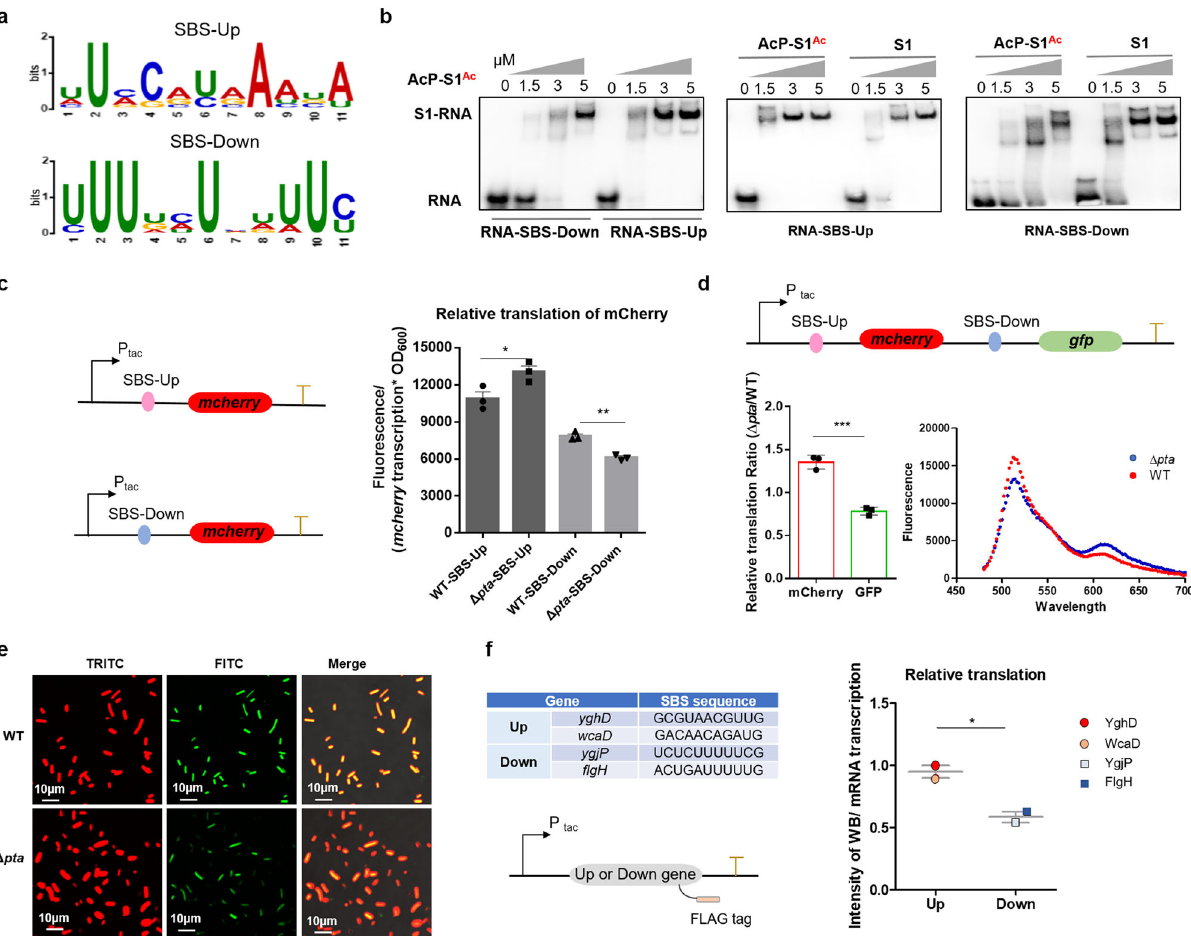
Fig. 4 The S1-binding sequence (SBS) plays a crucial role in acetylated S1-mediated translational regulation. a Analysis of conserved sequences of the top 50 up- or downregulated genes regulated by acetyl-mimetic S1. b Mobility-shift assay gels for the binding of S1 (WT) or AcP-S1 Ac with RNA containing SBS-Down (UUUUCUCUUUC) and RNA containing SBS-Up (UUCCAUAAAUA). c Relative translation of mCherry mRNA with SBS-Up or with SBS-Down in WT or Δ pta strain. The relative translation is equal to the relative fl uorescence unit (RFU)/the relative transcription level, RFU is equal to Fluorescence/ OD 600 . * P < 0.05, ** P < 0.01, *** P < 0.001. Three replicates were made for each sample. d Relative translation of SBS-Up-guiding mCherry and SBS-Down- guiding GFP in WT or Δ pta strain when cultured in acetate. * P < 0.05, ** P < 0.01, *** P < 0.001. Three replicates were made for each sample. e Intracellular mCherry and GFP in WT and Δ pta strains when cultured in acetate using confocal laser scanning microscopy. Scale bar: 10 μ m. f Relative translation levels of two target transcripts ( yghD and wcaD ) in Up-set and two target transcripts ( ygjP and fl gH ) in Down-set in the Δ pta strain when cultured in acetate. * P < 0.05, ** P < 0.01, *** P < 0.001. Three replicates were made for each plasmids and expressed in the Δ pta strain cultured in acetate (Fig. 4f). The transcriptional levels (RT-qPCR) and protein amounts (Western-bloting assay) of the target genes were determined (Fig. S4b, c). Quanti fi cation of relative translation showed a signi fi cant difference in the protein outputs of ygjP and fl gH compared to yghD and wcaD (Fig. 4f). Previous works have shown that an A/U-rich sequence upstream of the RBS (ribosome-binding site) facilitates translation 35,36 . Our fi ndings strongly point to a direct role for SBS in acetylated S1-mediated translational regulation depending upon the differential binding af fi nities of S1 and acetylated S1 to SBS of distinct mRNAs.